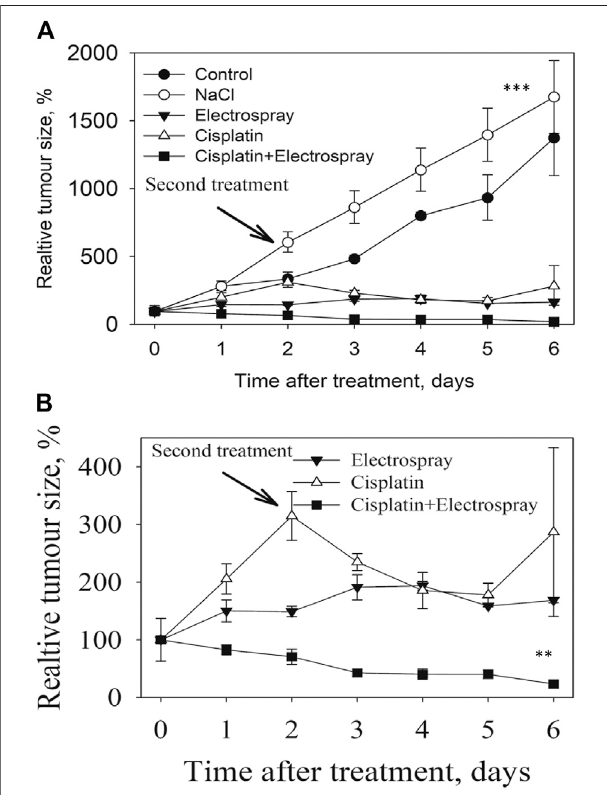
FIGURE 5 | Tumor volume measured in different experimental groups (A) . Tumor volume of the three treated groups for better visualization of data (B)